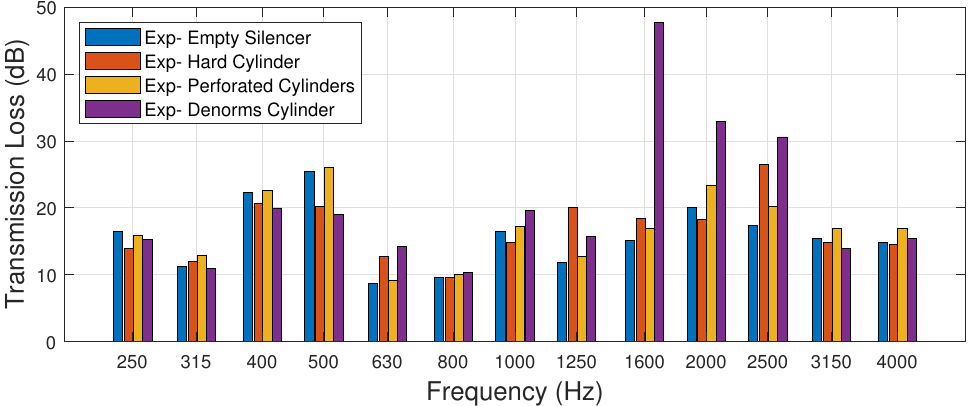
Figure 14. Experimental cylinder type comparison as a function of third octave